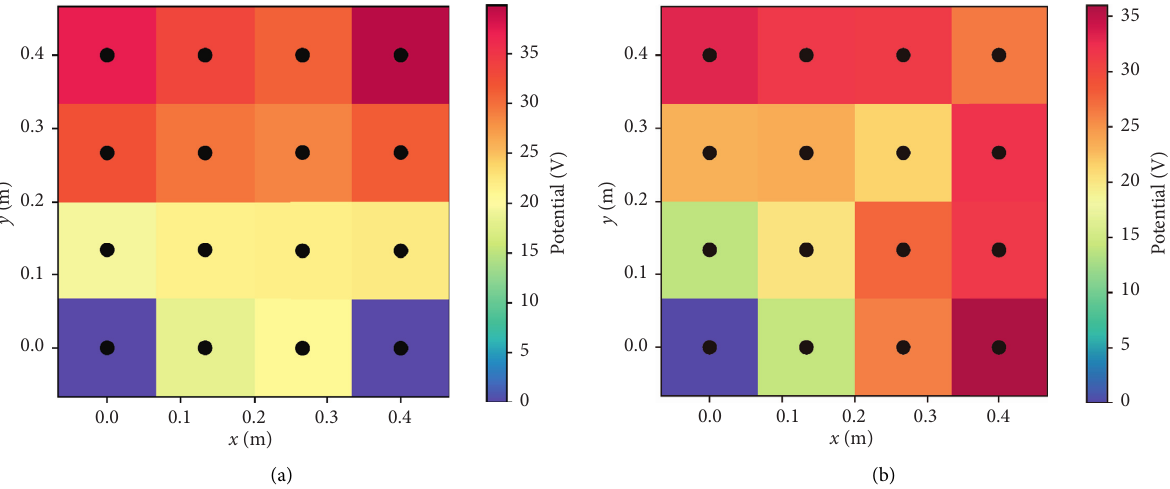
Figure 7: Potential distribution of test model. (a) The potential distribution of the symmetric unit. (b) The potential distribution of the asymmetric unit.